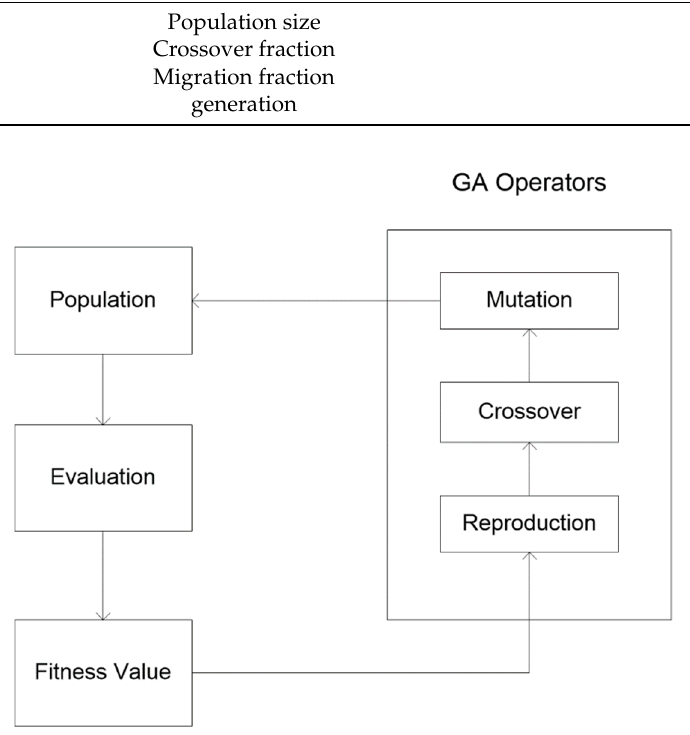
Figure 6. Flow Chart of GA method.